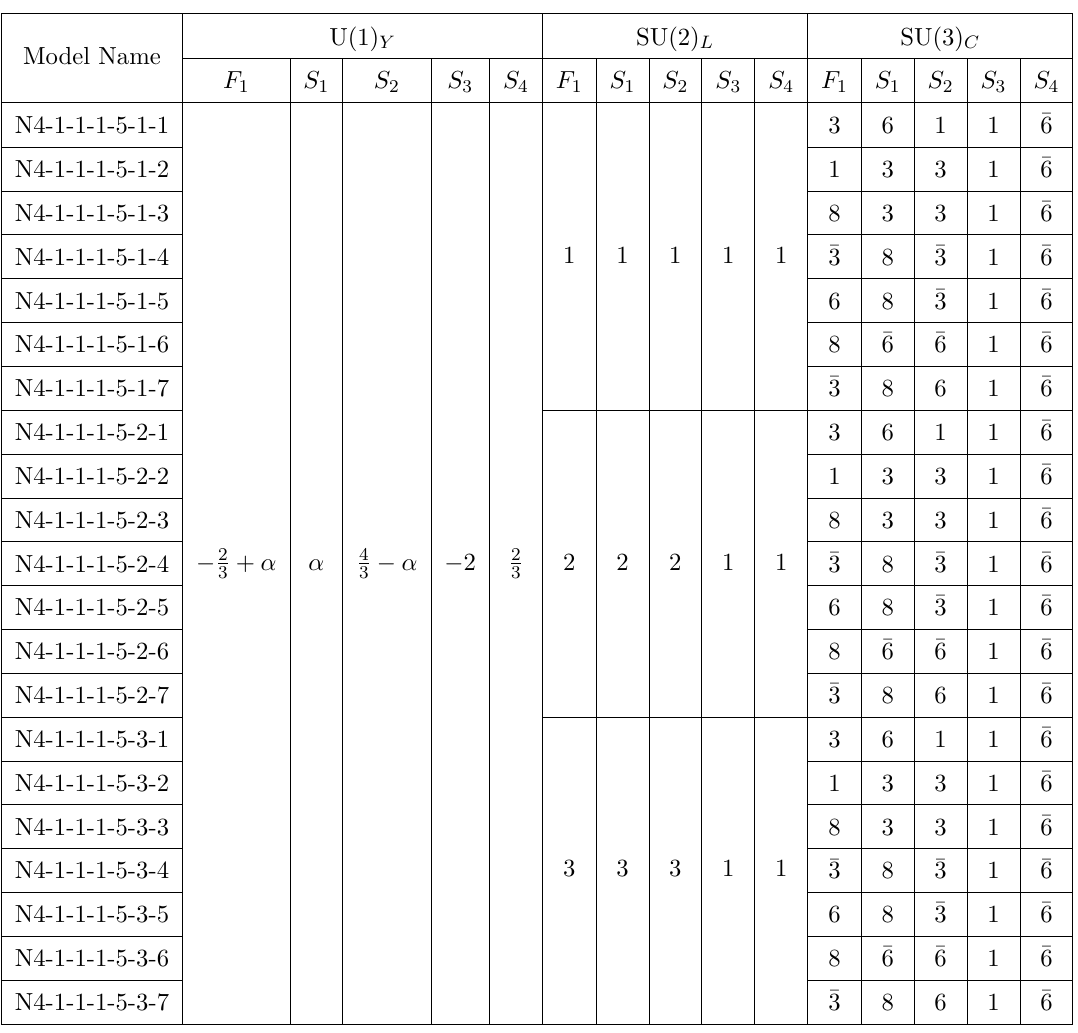
Table 10 . The one-loop models for the 0 νββ decay operator N4 arising from the diagram N4-1-1- 1-5 shown in figure